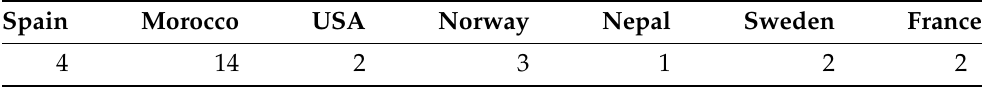
Table 9. Students’ countries of